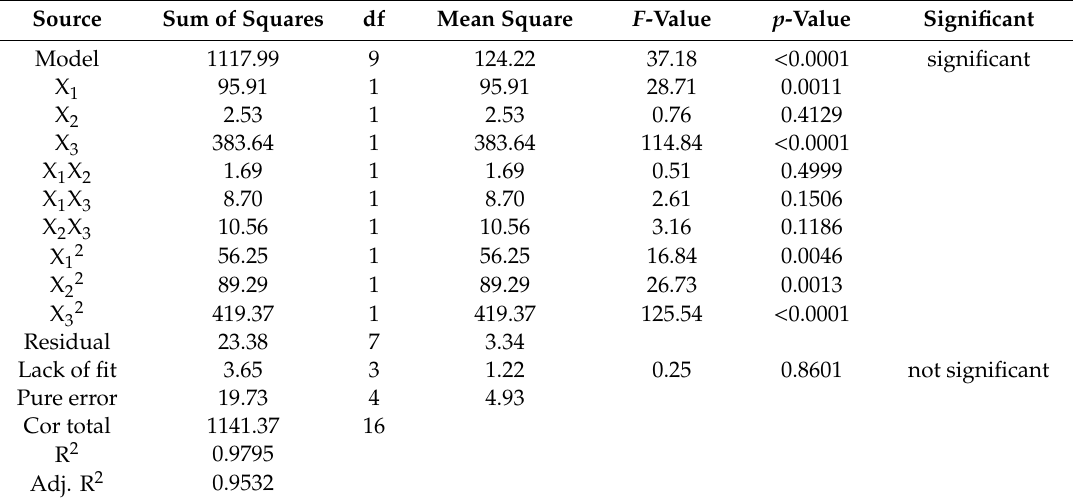
Table 4. Analysis of variance (ANOVA) of the response surface